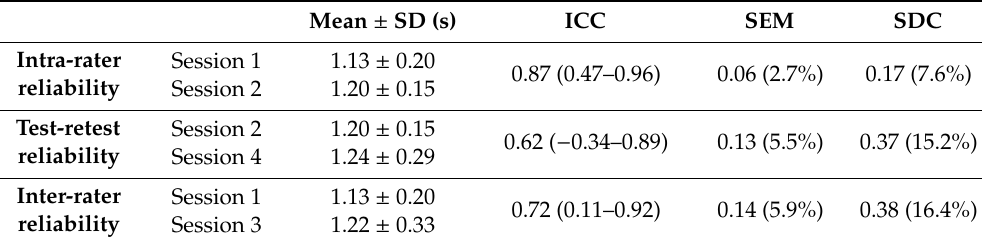
Table 6. Results for gait cycle duration.